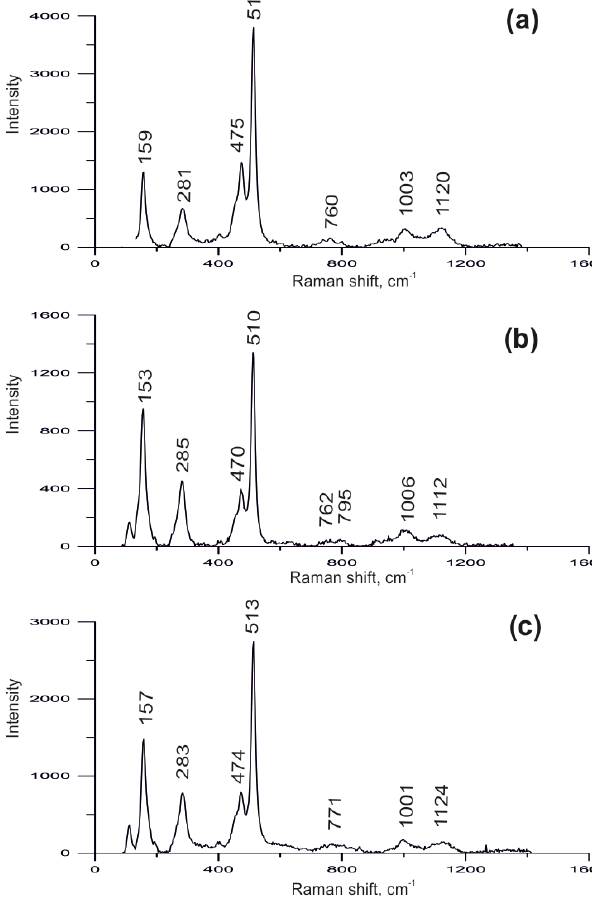
Figure 3. The Raman spectra of sanidine from the Arsenatnaya fu- marole (a) , the Yadovitaya fumarole (b) and the ancient fumarole of Mountain 1004 (c) , all from the Tolbachik